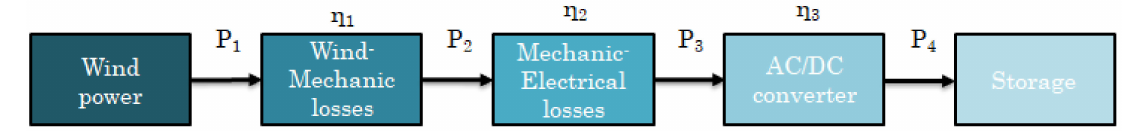
Figure 1. Block diagram of complete harvester Alternate Current (AC)